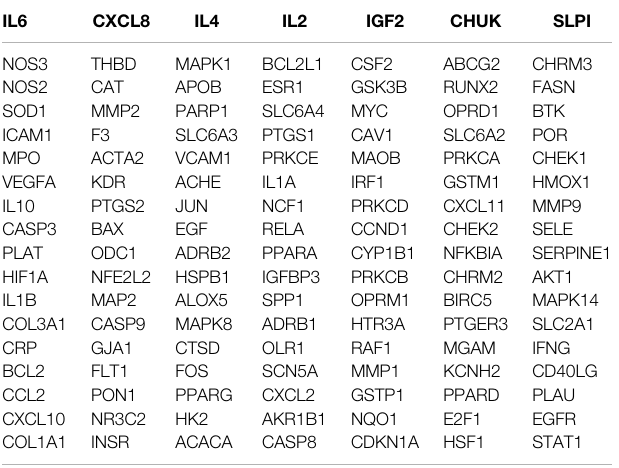
TABLE 3 | Intersection genes for ZLH and cerebral ischemia – reperfusion.